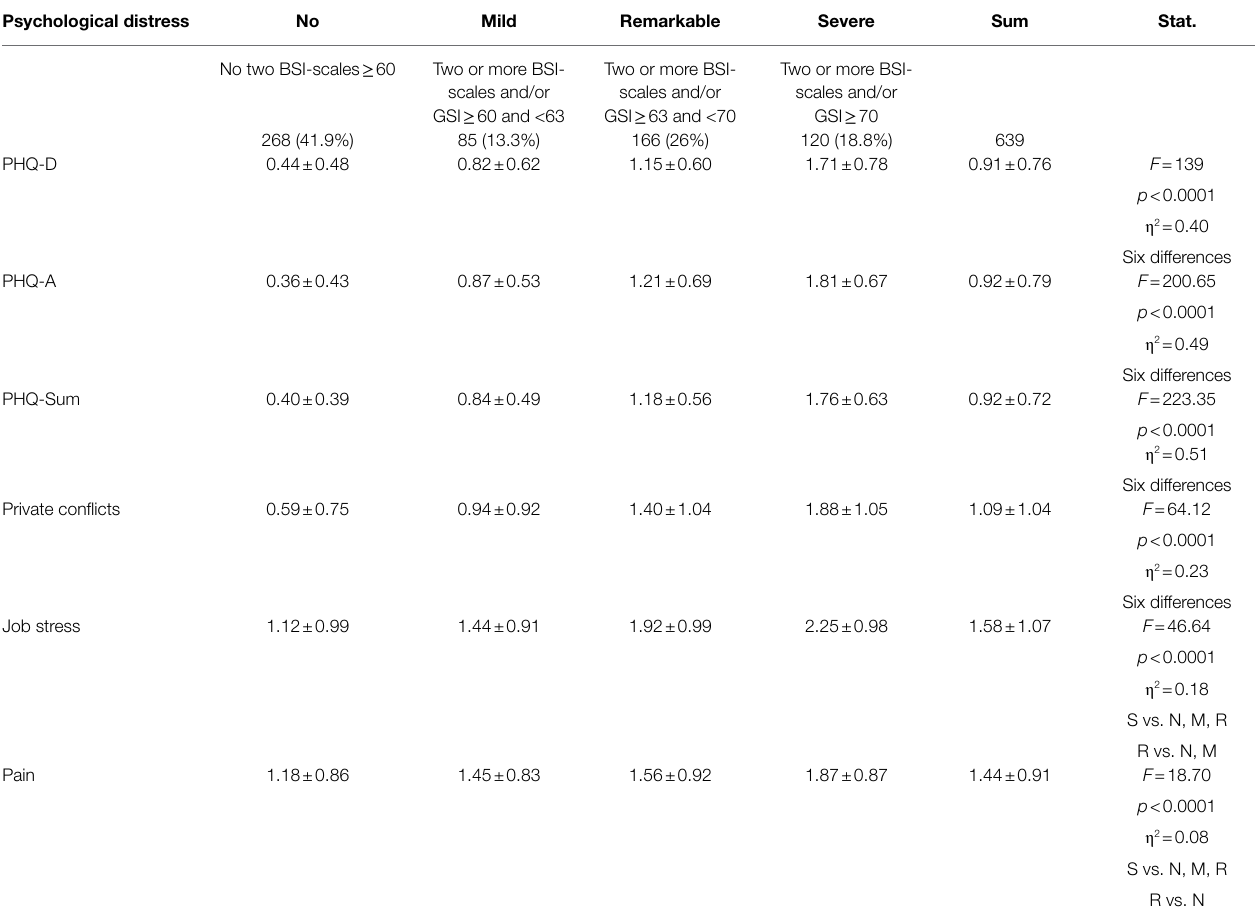
TABLE 3 | Differences between the four different psychologically distressed groups regarding patient health questionnaire (PHQ) and questions about private conflicts, job stress, and pain (mean and SD). Psychological